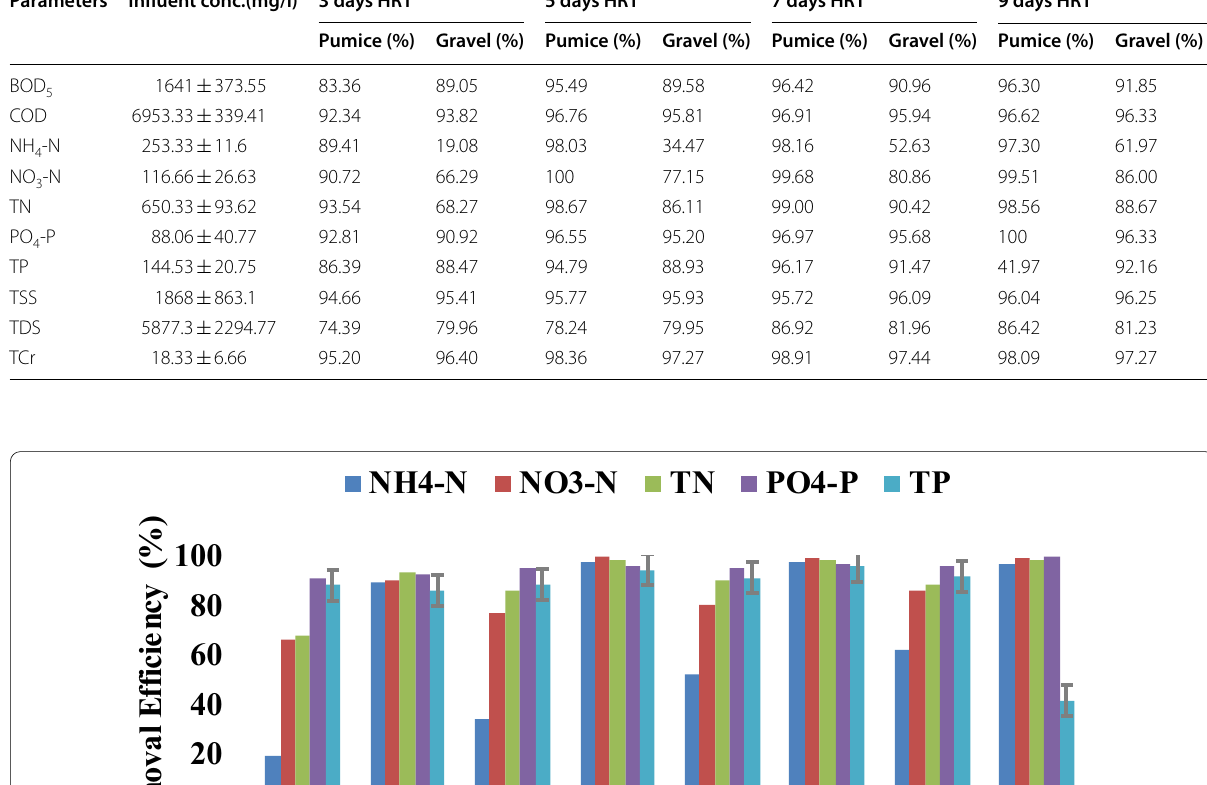
Table 4 TWW Treatment Efficiency of HSSFCW with Gravel and Pumice Substrate and Planted with CZ at Different HRT Parameters Influent conc.(mg/l) 3 days HRT